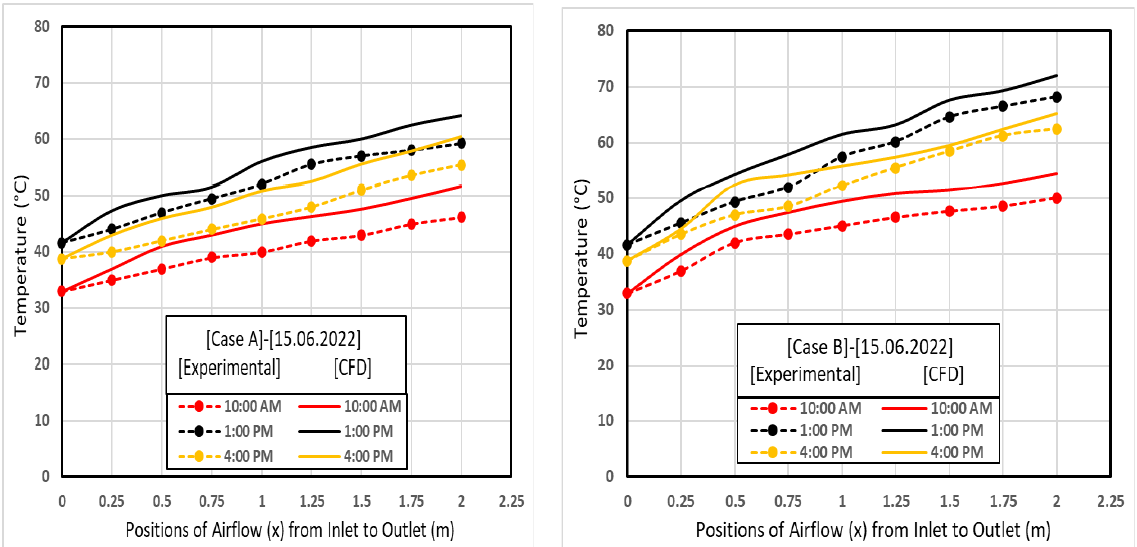
Figure 15. Validation of the CFD airflow temperatures variation and the experimental data for the Case A and Case B FPSAHs tested at various time intervals.